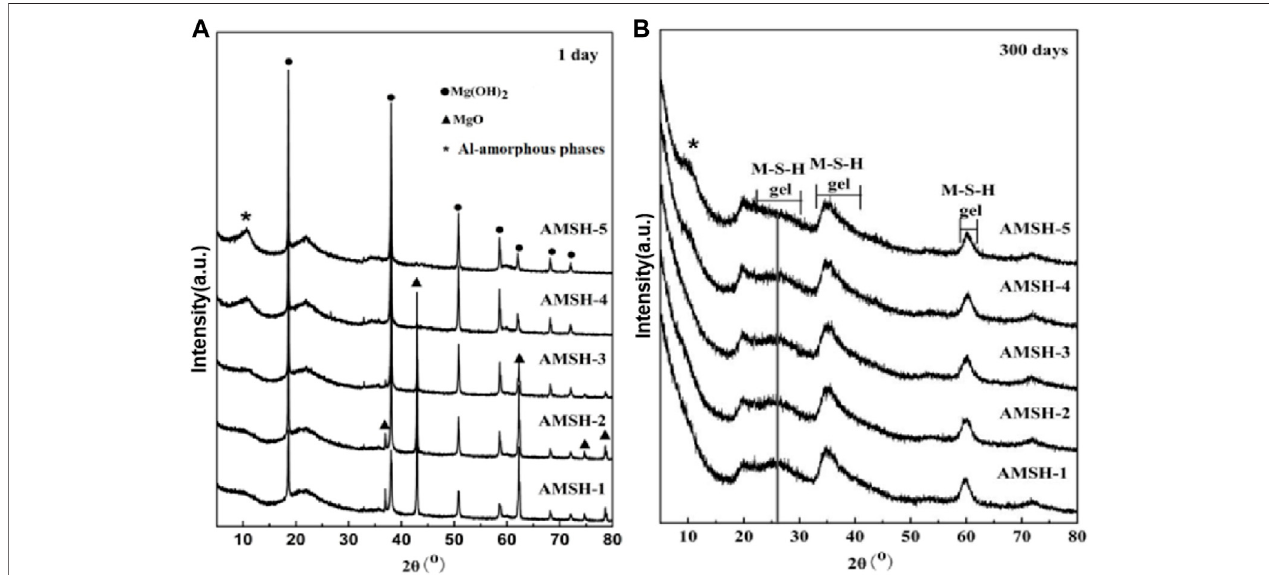
FIGURE 1 | The XRD patterns of magnesium silicate hydrate (M-S-H) samples with different Al 3+ contents after curing for (A) 1 day and (B) 300 days.